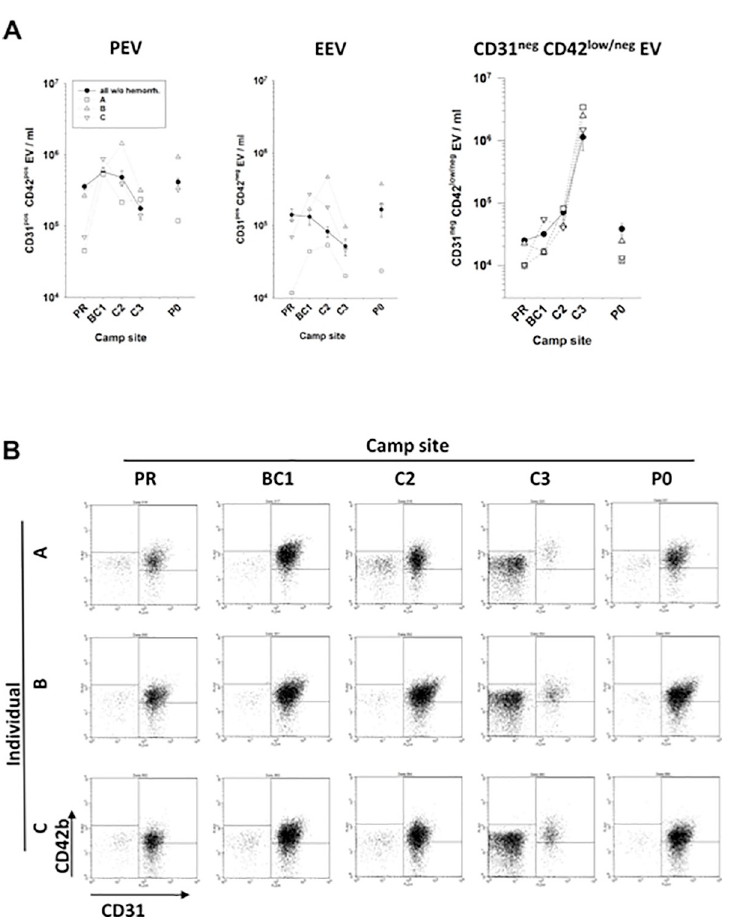
Fig 3. Analysis of the AnnexinV pos extracellular vesicles of individuals with cerebral microhemorrhages. Plasma samples of mountaineers were analysed by flow cytometry as described in Fig 1. (A) Amounts of PEV, EEV, and CD31 neg CD42b low/neg EV in the plasma of the individuals A, B, and C (open symbols) in comparison to the mean +/- SE values of all non-hemorrhagic peers (closed symbols). (B) Dot plots of CD31 and CD42b expression on AnnV pos EV of individuals A, B, and C at the various camp sites.